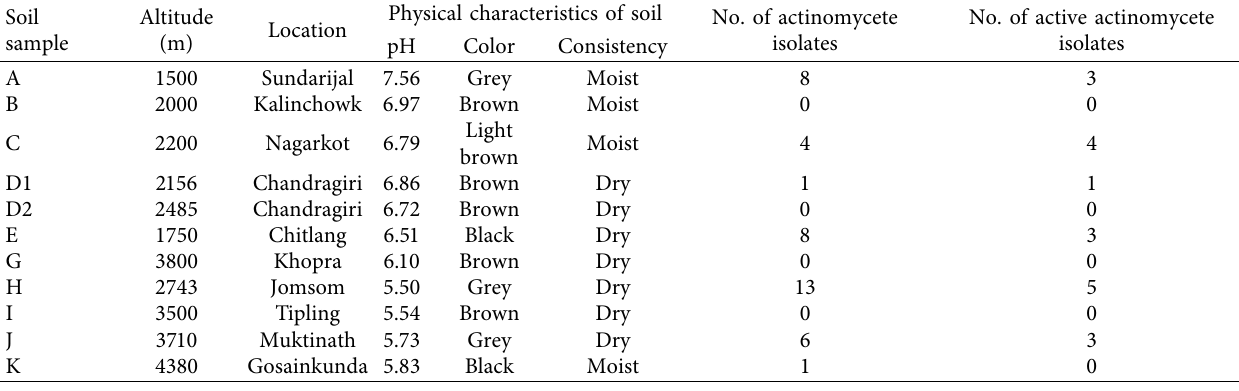
Table 1: Description of soil samples along with the total number of isolates and active isolates.